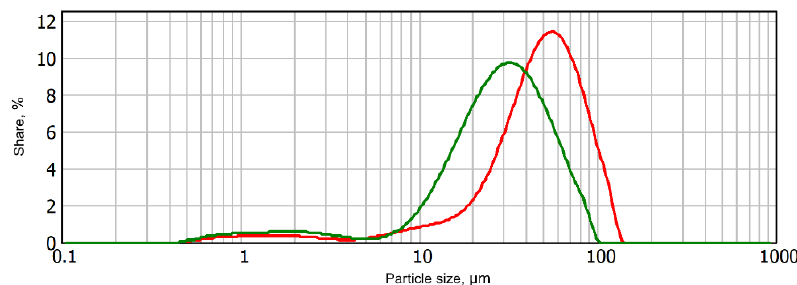
Figure 10. Raw digestate liquid fraction particle size distribution (red line—without sonication, green line—with sample sonication).